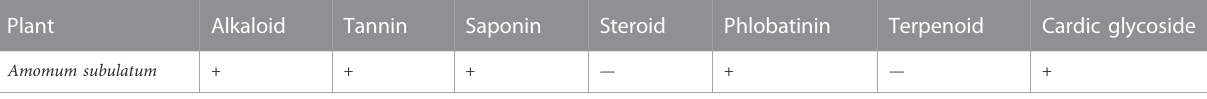
TABLE 1 Qualitative analysis of the phytochemicals of the Amomum subulatum seeds extracts. Plant